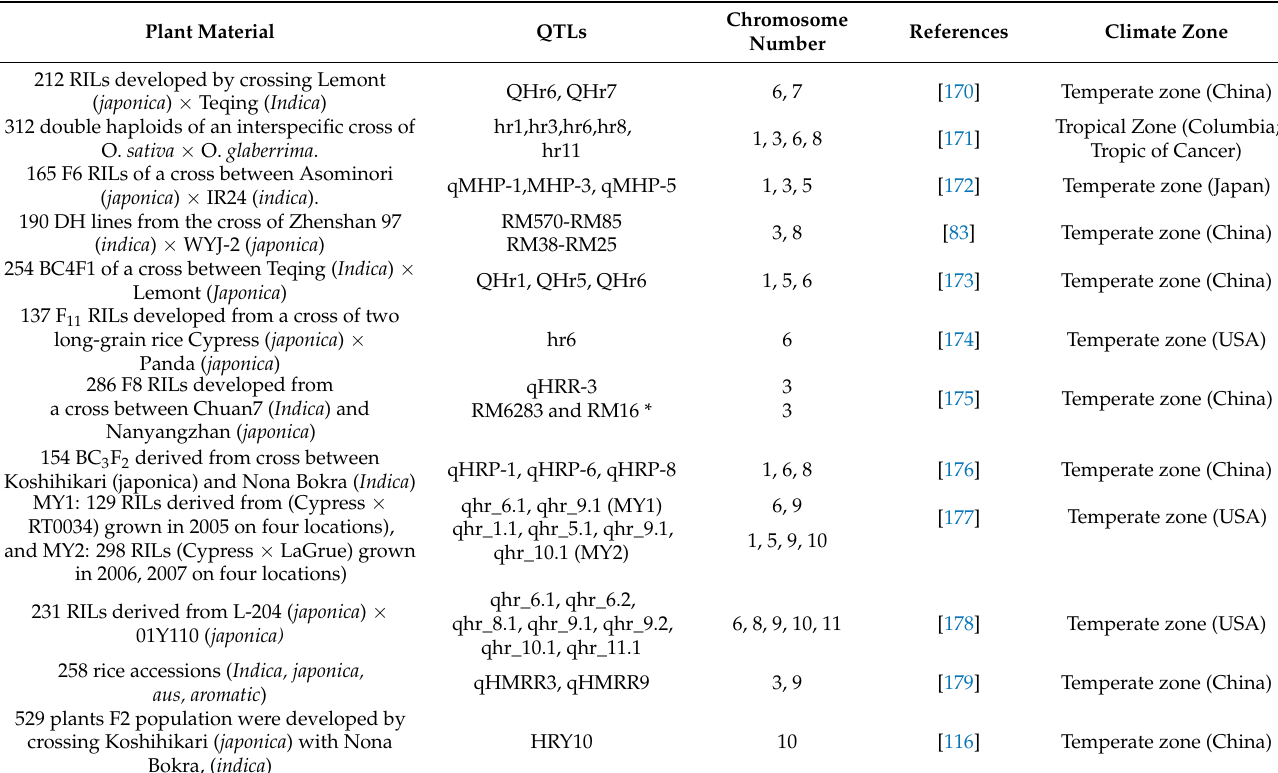
Table 7. Quantitative traits loci for percentage head rice yield (the amount of whole grain polished white rice of the paddy from which it is derived and then multiplied by